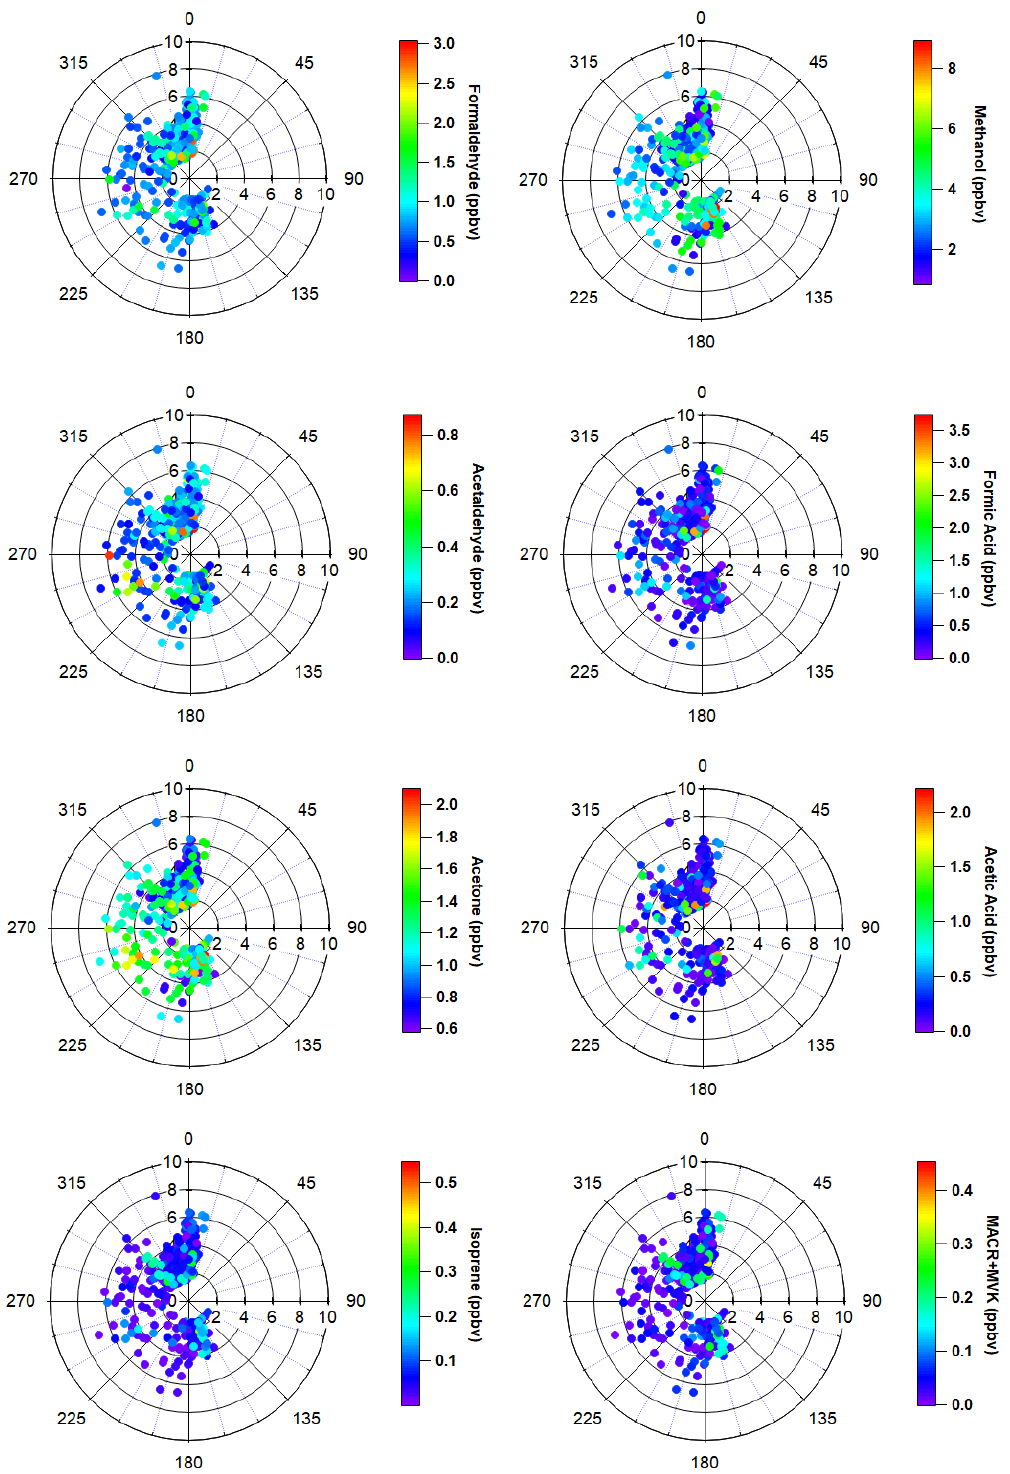
Figure 4. Polar wind plots of hourly wind speed, wind direction and VOC mixing ratios (color scales, ppbv). Distance from the radius represents wind speed. Data have been filtered for local pollution and stagnant